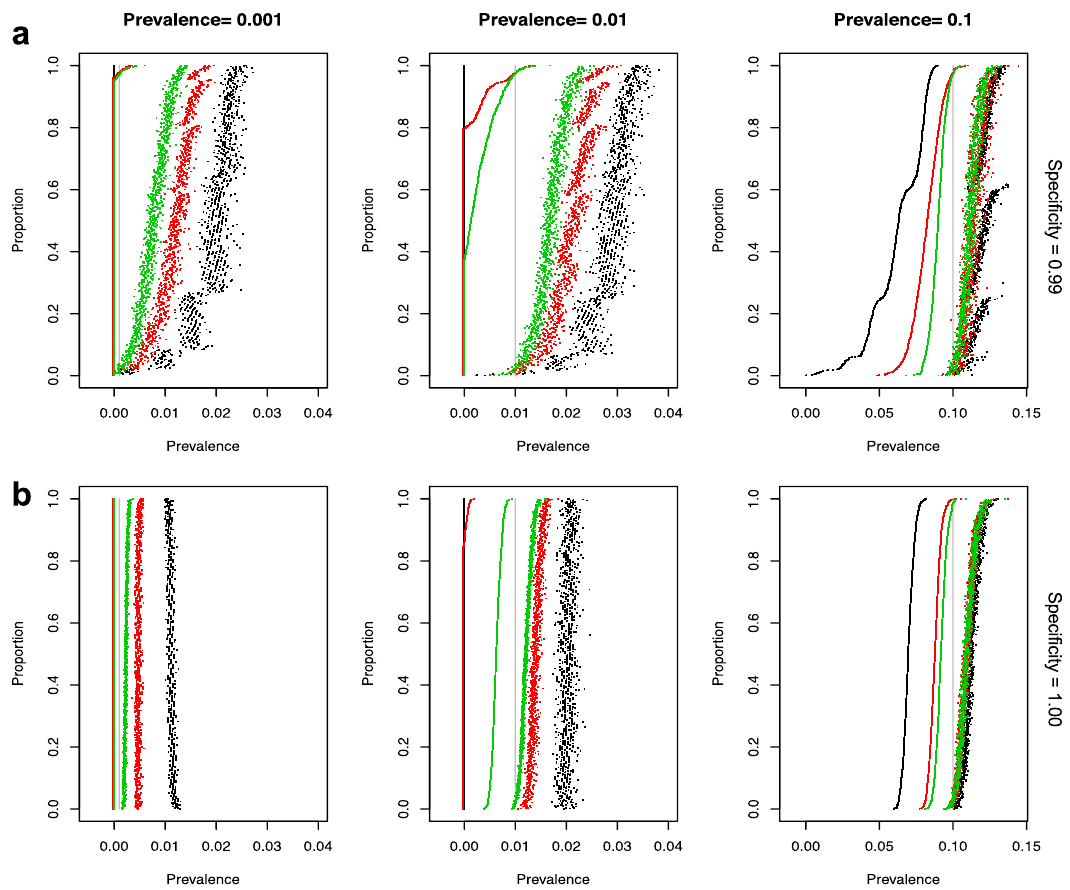
Fig. 7 Simulation results showing con fi dence intervals for serosurvey prevalence calculations. Each graph displays 95% con fi dence intervals (CI) for the estimate of prevalence from 1000 replications of each condition (including estimating the sensitivity and speci fi city for each replicate). The CIs are sorted by the lower bound, with lower bounds less than 0 replaced by zero. For all graphs, the true sensitivity is 0.90 and the simulations use 100 samples to estimate the sensitivity. For the graphs in row a the true speci fi city is 0.99 and in row b the true speci fi city is 1.00. The graphs show the simulations results with estimates of speci fi city using sample sizes of 100 (black), 300 (red), 1000 (green). Points are plotted black, red, then green, so some of the black and green points may be covered (e.g., the lower bounds for all three colors are all zeros in the bottom left panel). The columns give results for true prevalence values of 0.001, 0.01, or 0.1. The true prevalence for each simulation is shown by a vertical gray